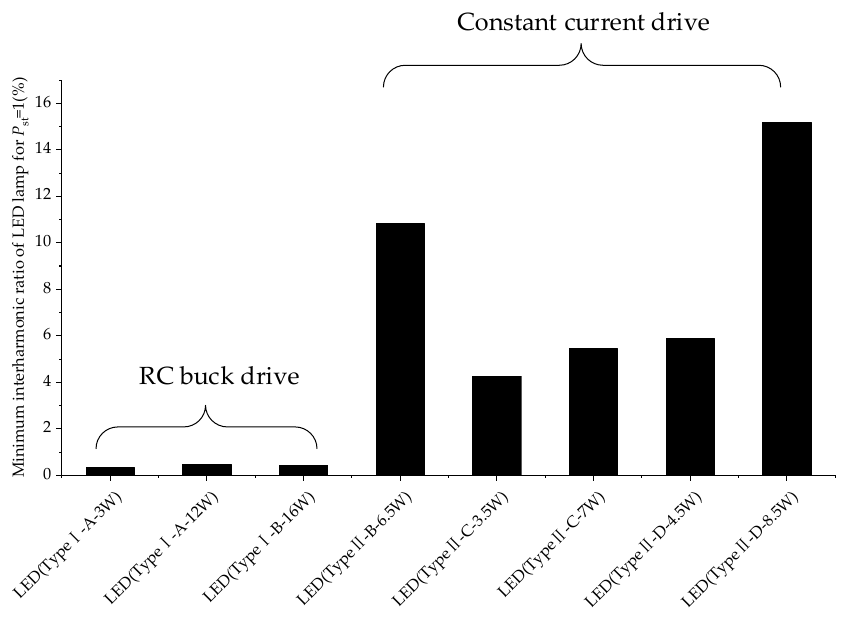
Figure 9. Minimum interharmonic ratio of out-of-limit flicker.